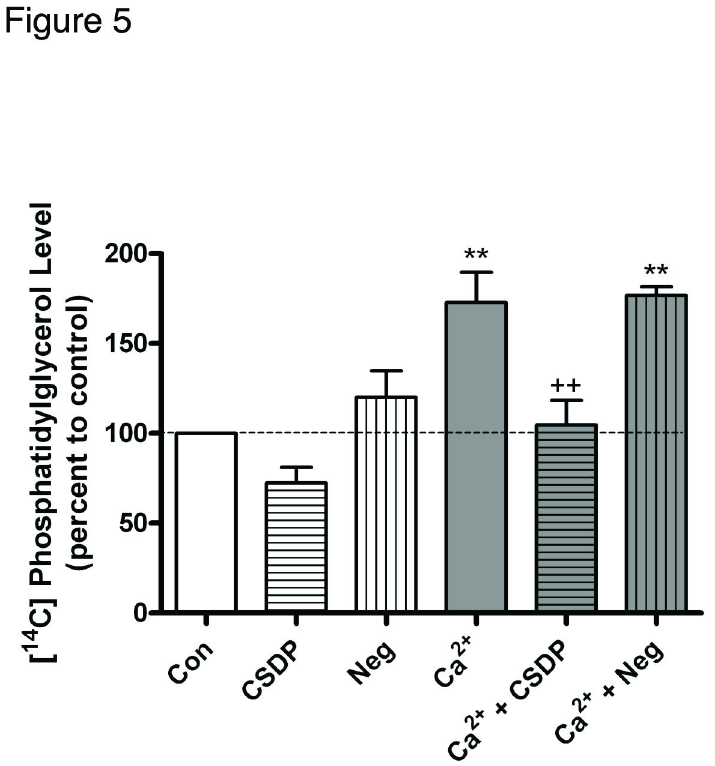
Figure 5. The caveolin-1 scaffolding domain peptide decreases calcium-increased phosphatidylglycerol levels. Keratinocytes were treated for 24 hours with SFKM containing vehicle (0.1% DMSO) or 3 μM caveolin-1 scaffolding domain peptide (CSDP) or the negative control (Neg) in medium containing 25 μM calcium (Con) or 125 μM calcium (Ca 2+ ) as indicated.. [ 14 C]Phosphatidylglycerol levels were then measured as described in Materials and Methods. Values are expressed as the percent control and represent the means ± SEM of 3 separate experiments performed in duplicate; **p<0.01 versus the control